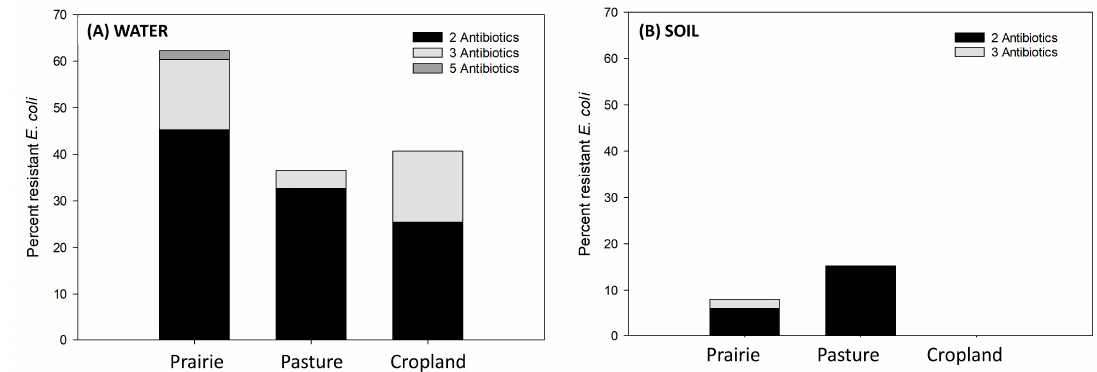
Figure 4. Percentage of multidrug resistance (MDR) observed within E. coli isolates in the three sites Prairie, Pasture and Cropland isolated from ( A ) water runoff and ( B ) soil.